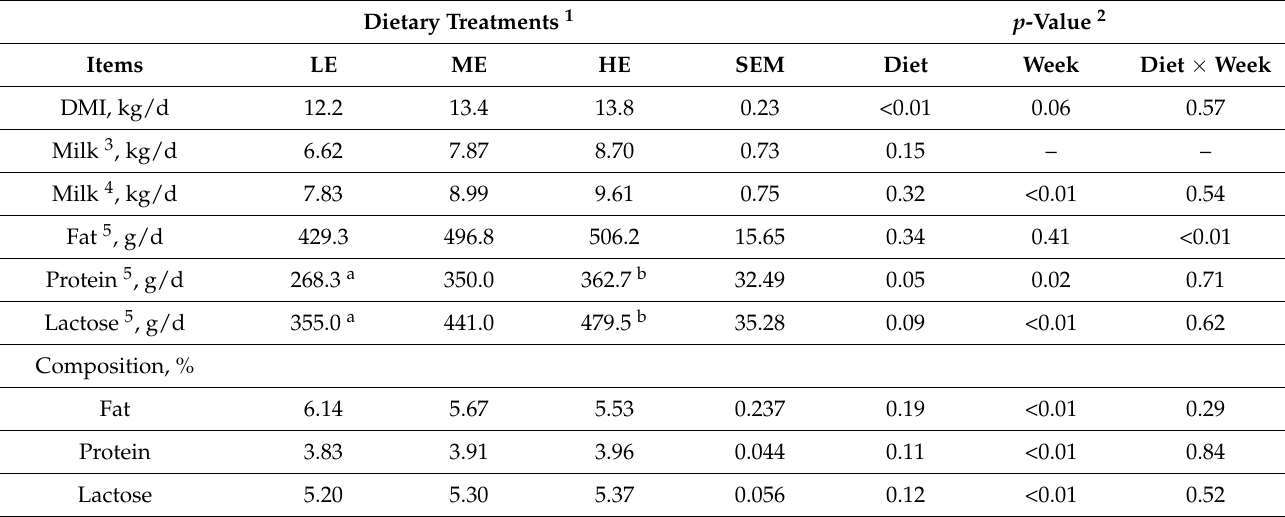
Table 2. Production performance of Nili Ravi buffaloes fed different levels of energy. Dietary Treatments 1